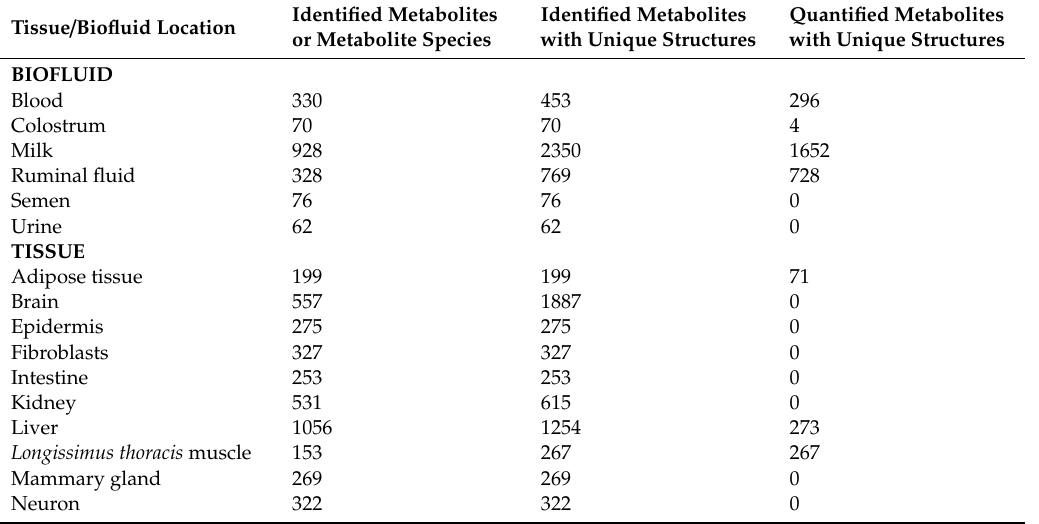
Table 2. Metabolome coverage of di ff erent bovine biofluids and tissues in the BMDB. Tissue / Biofluid